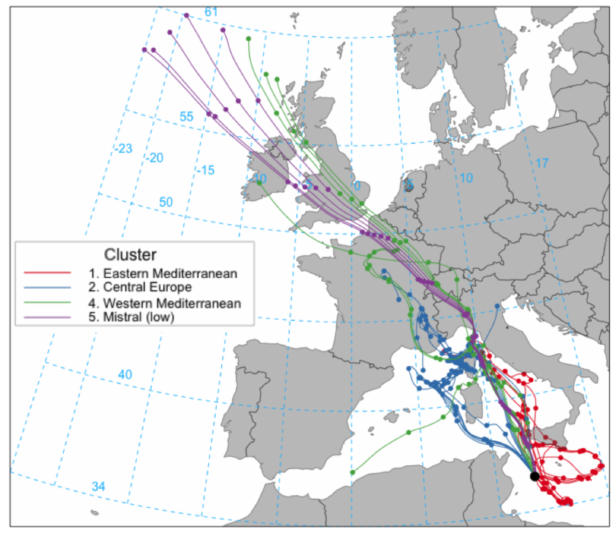
Figure 14. Hourly 120h (5d) back trajectories from Lampedusa that passed within ± 1 ◦ in latitude and longitude and ± 200m in al- titude of the Ersa station. The colours represent the assigned cluster (performed on 144h trajectories).